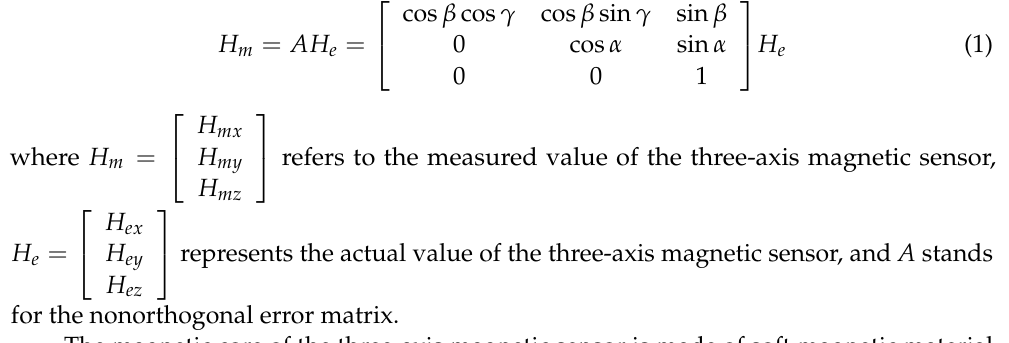
 represents the actual value of the three-axis magnetic sensor, and A stands for the nonorthogonal error matrix. The magnetic core of the three-axis magnetic sensor is made of soft magnetic material with high permeability and low coercivity, which reaches its saturation state under external excitation that is then converted to the voltage value. After that, it collects the change in the measured magnetic field. The sensor contains detector circuit, integral filter circuit, and signal feedback circuit, etc. Different characteristics of electronic components in the circuit lead to differences in the sensitivity of the three axes. If only the sensitivity factor error is considered,